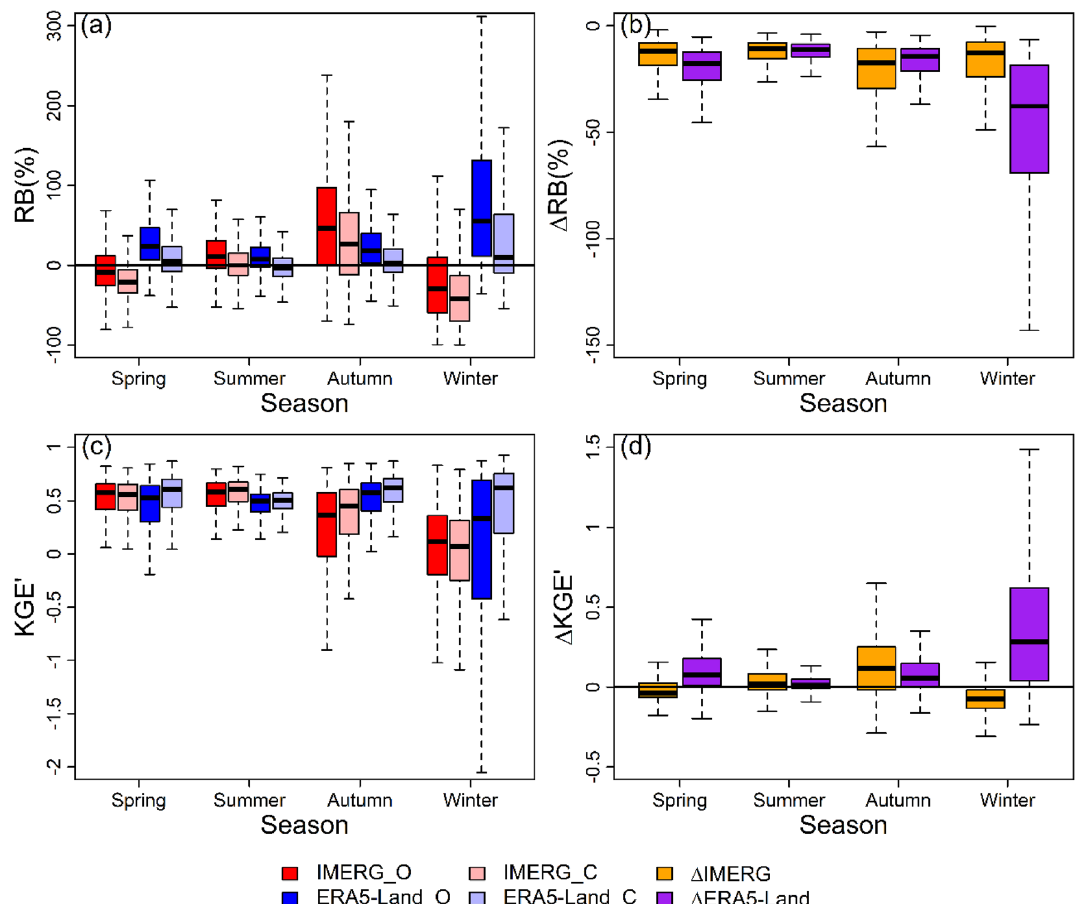
Figure 7. Boxplots of ( a ) RB (RB_O and RB_C), ( b ) ∆RB, ( c ) KGE ʹ (KGE ʹ _O and KGE ʹ _C), and ( d ) ∆KGE ʹ for IMERG and ERA5-Land at the seasonal scale.